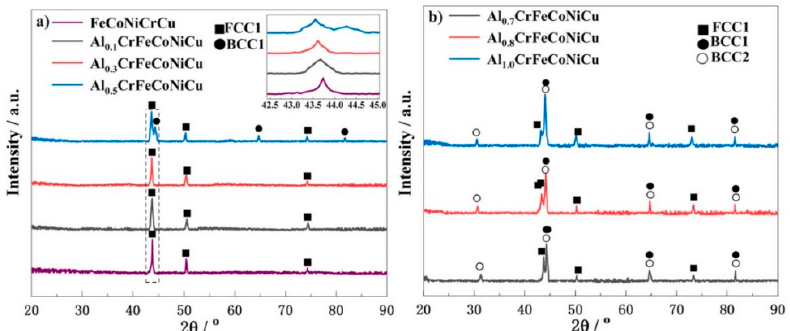
Figure 6. XRD patterns of Al x CrFeCoNiCu HEA coatings. ( a ) coatings with low Al content, ( b ) coatings with medium-Al content. Reprinted with permission from Ref. [64]. Copyright 2021 Elsevier.